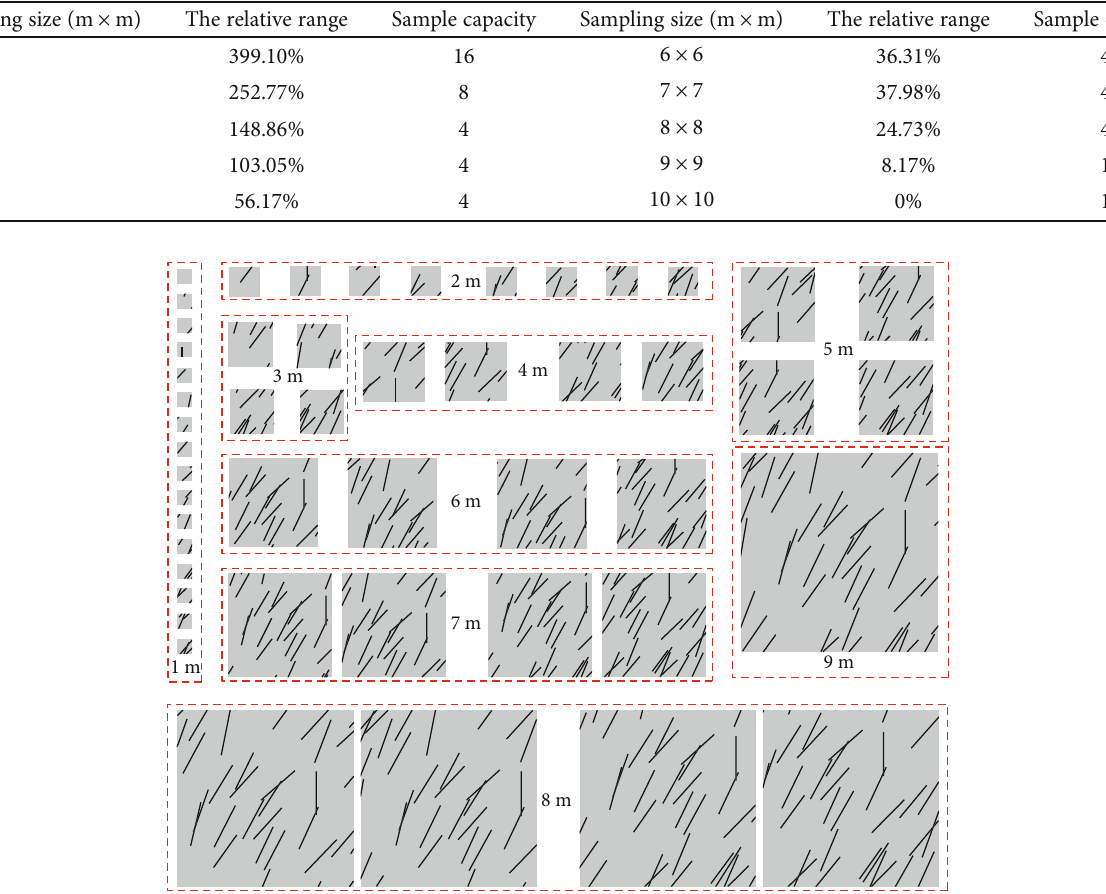
Figure 6: Sample distribution statistics of di ff erent